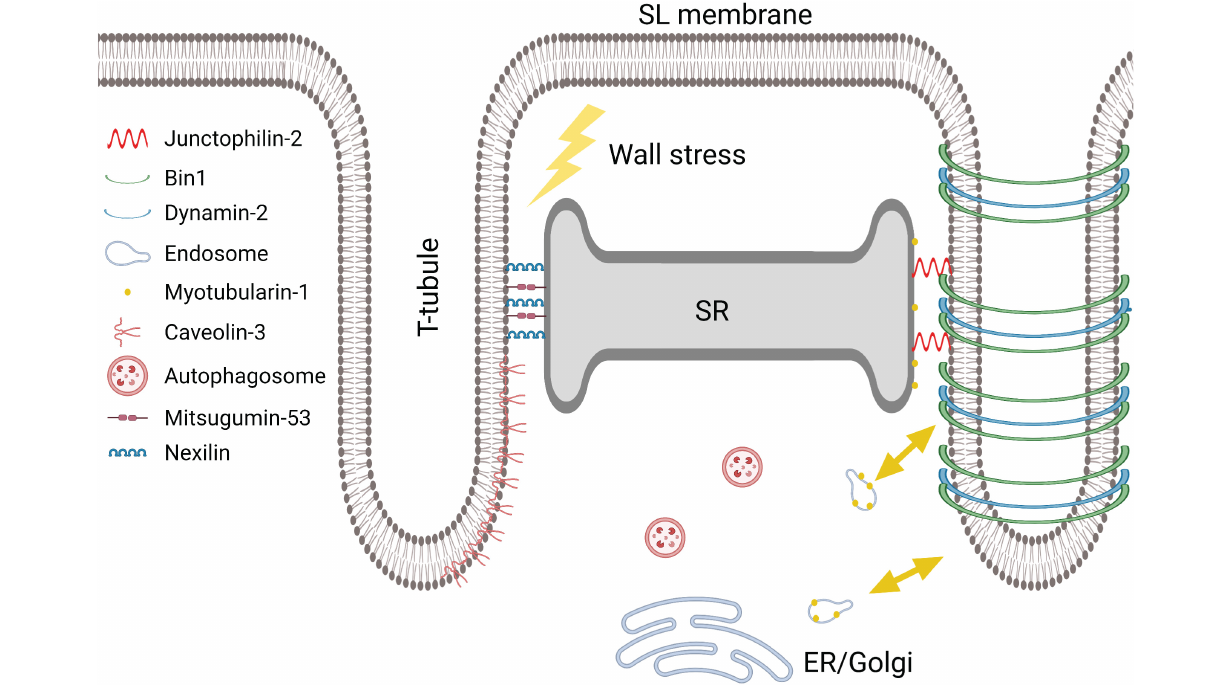
Frontiers in Physiology |